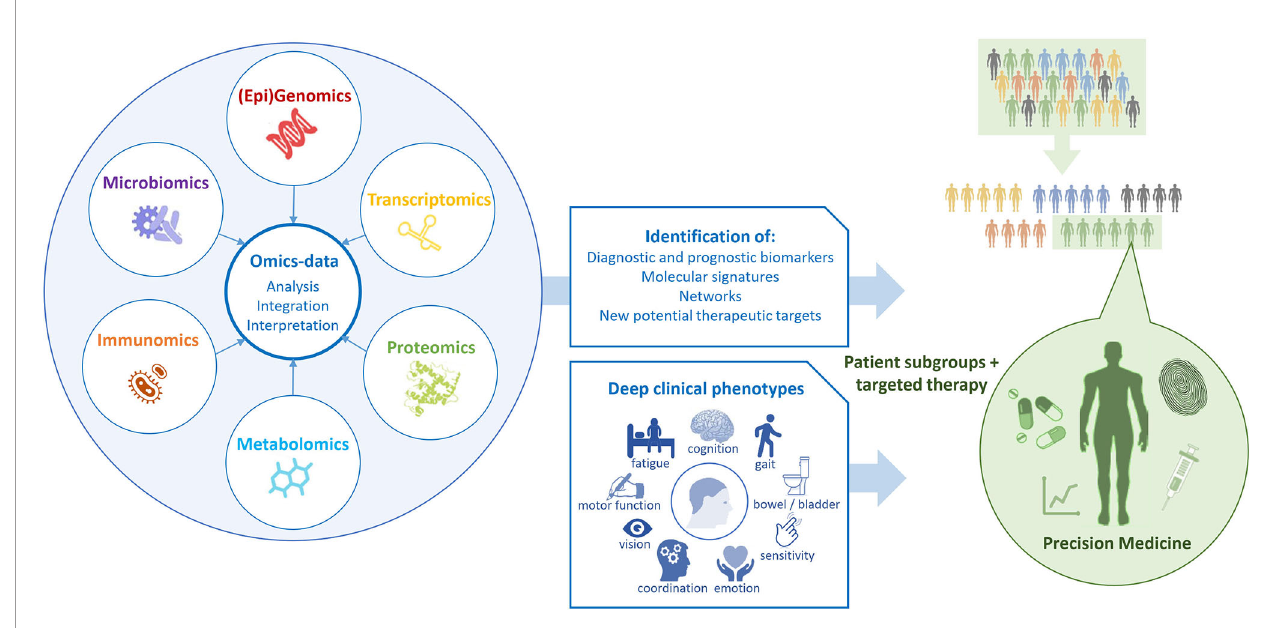
FIGURE 2 | Multi-omics for precision